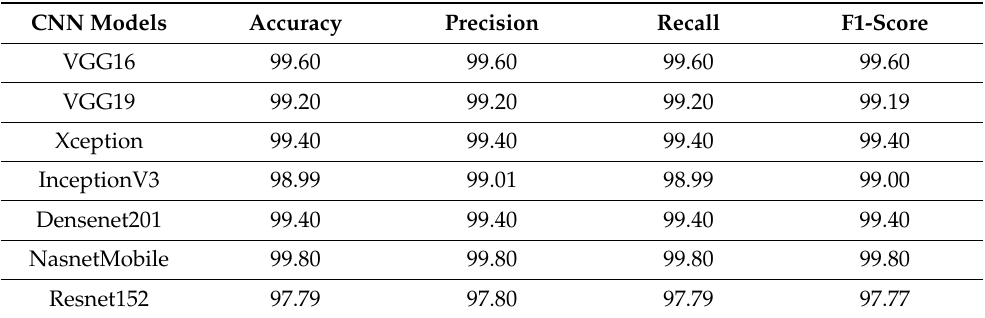
Table 3. Weighted average of performance metrics by different deep learning models for COVID-19 and viral pneumonia classification.